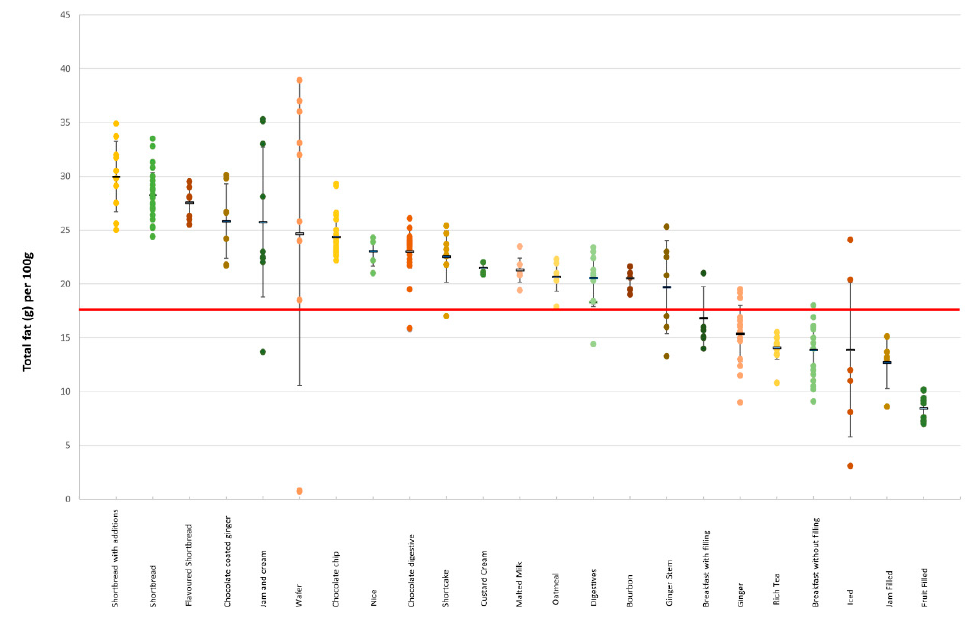
Figure 4. Total fat content (g/100 g) in different categories of biscuits. The red line denotes the high criteria for total fat.